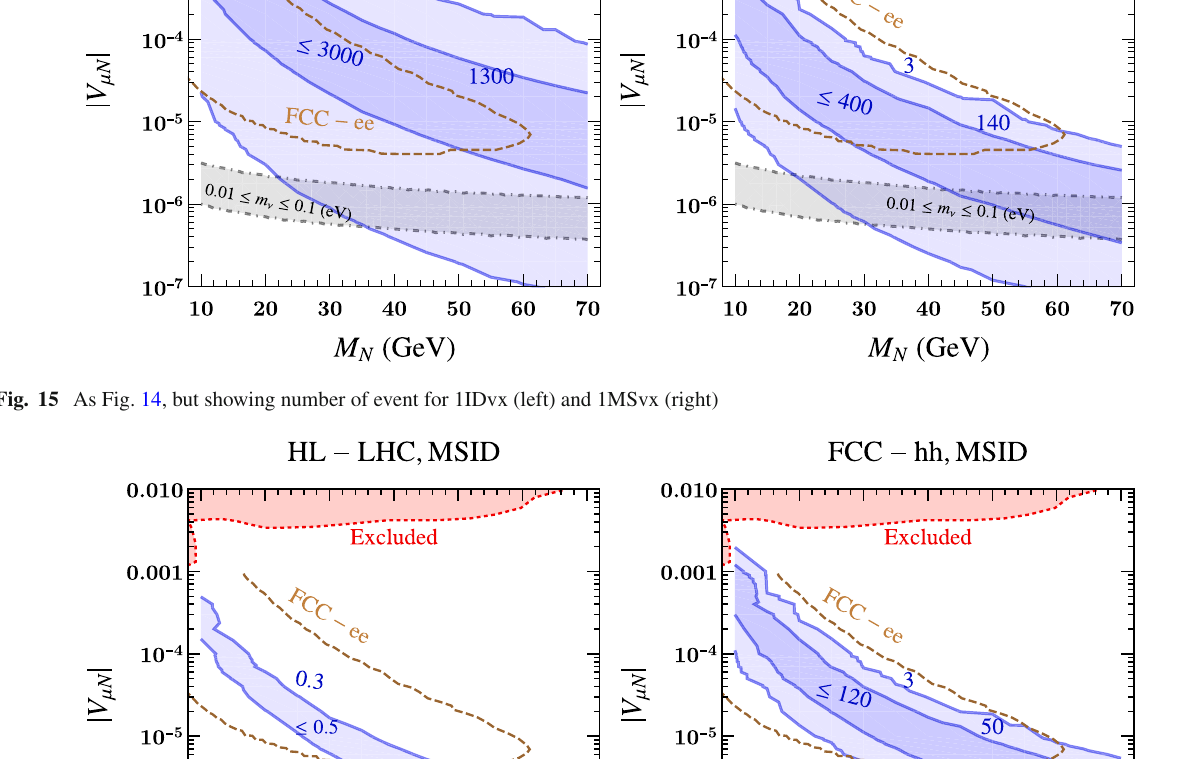
(left panel) and 2MSvx (right panel). The region inside